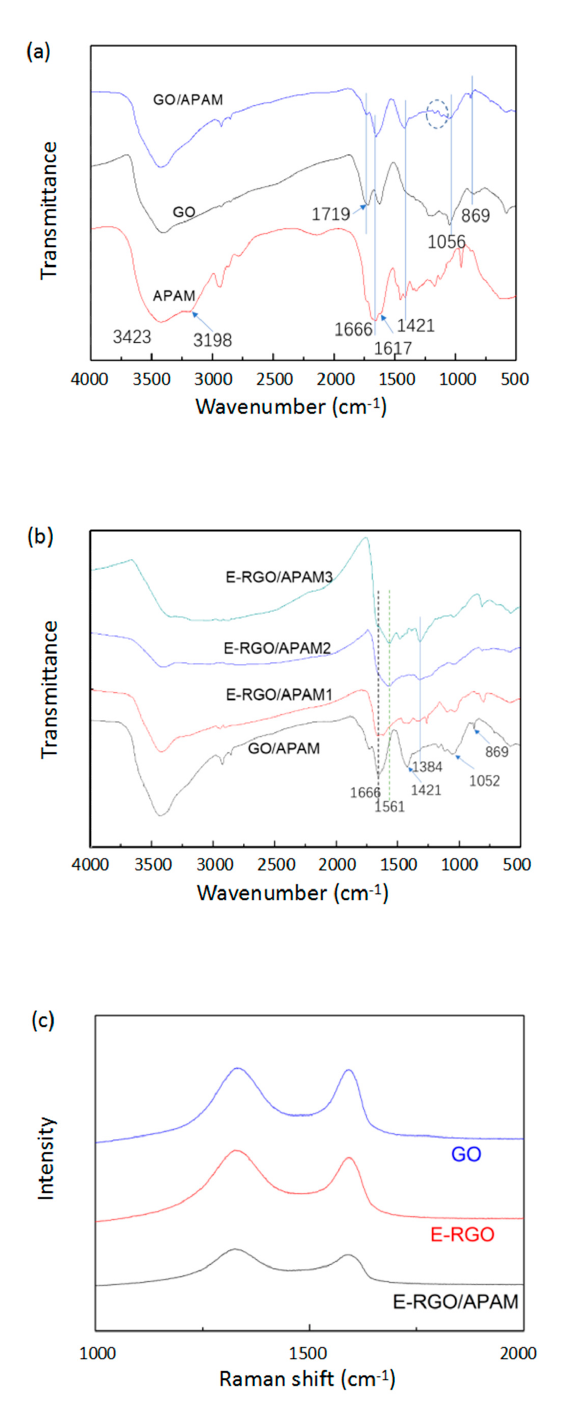
Figure 2. ( a ) FT-IR spectrum of APAM, GO, GO / APAM; ( b ) FT-IR spectrum of E-RGO / APAM with ethylenediamine dosage of (1–3) 0.1, 0.5, 1.0 mL, respectively; ( c ) Raman scattering spectrum of GO, E-RGO, E-RGO /